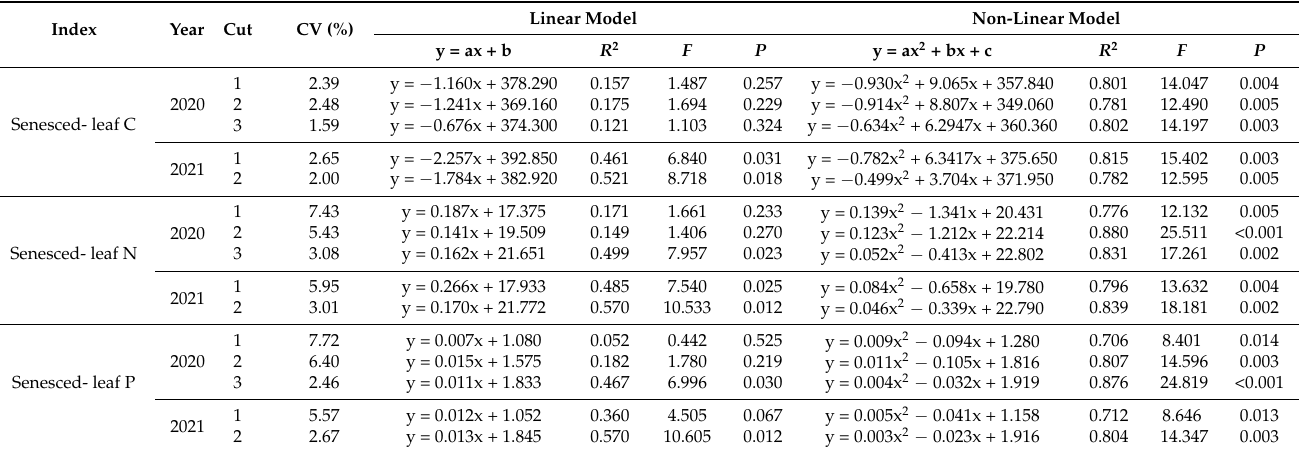
Table 3. Correlation analysis between fall-dormancy levels and C, N, and P concentrations in senescent alfalfa leaves